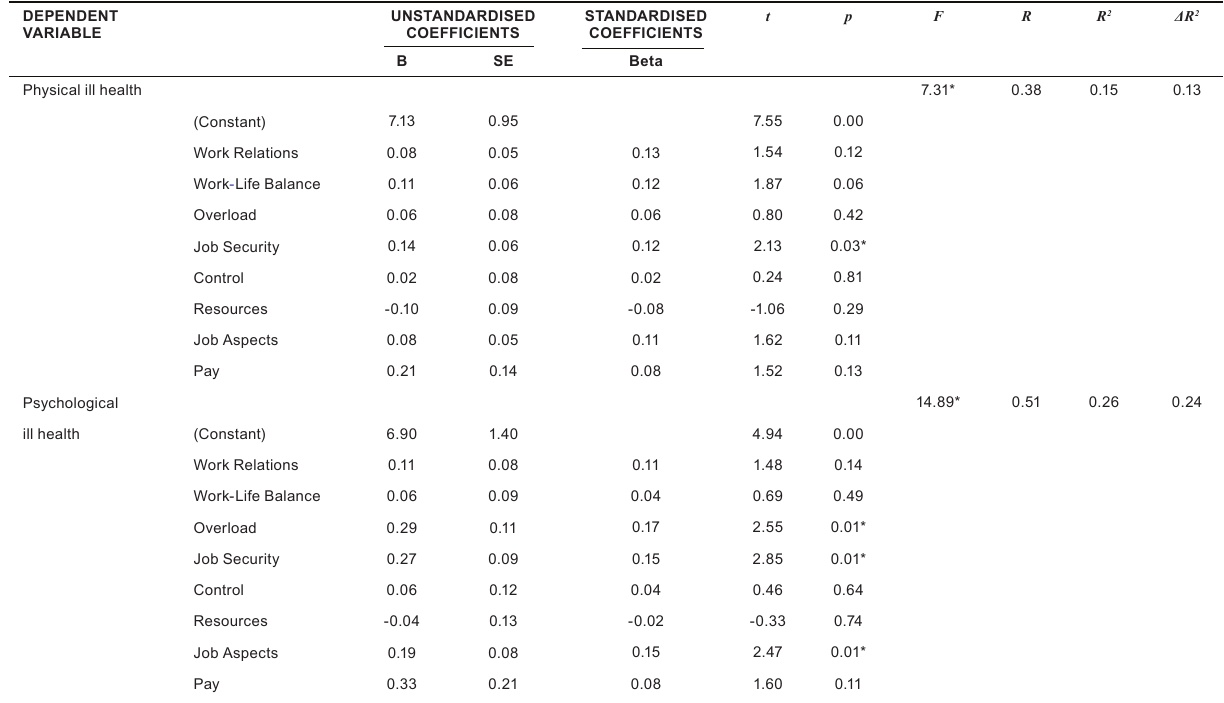
taBLe 3 Standard multiple regression analysis with physical and psychological ill health as dependent variables